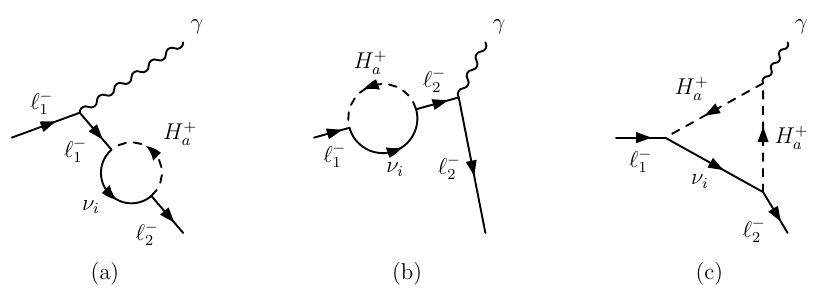
Figure 13 . The three diagrams for ‘ 1 − → ‘ 2 − γ with a loop containing H ±